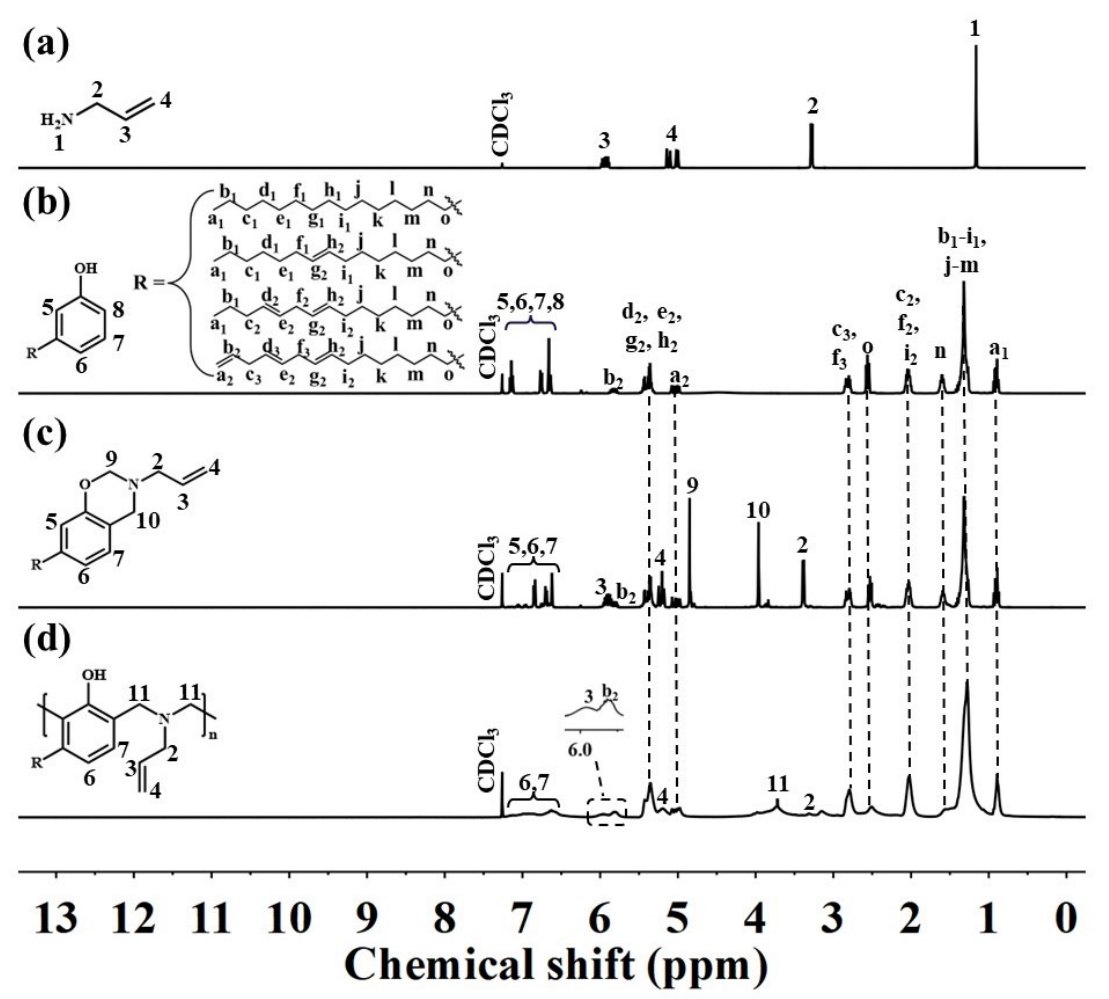
Figure 2. 1 H NMR spectra of allylamine ( a ), cardanol ( b ), BZ monomer ( c ), and OBZ ( d ).